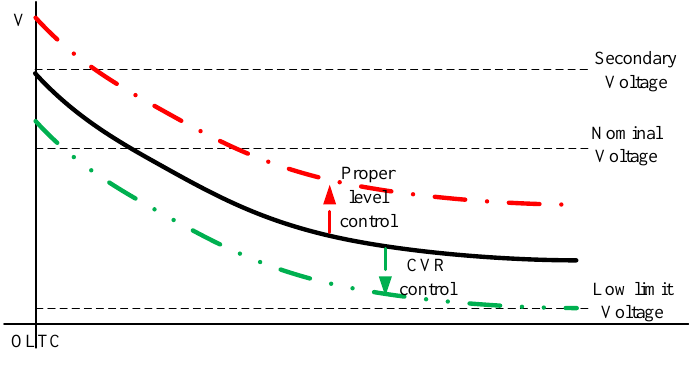
Figure 12. Voltage variation by tap changing device.